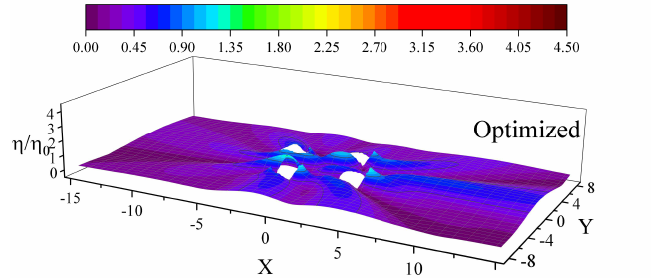
Figure 17. The scattered-wave elevation of optimized structure at k 0 a =